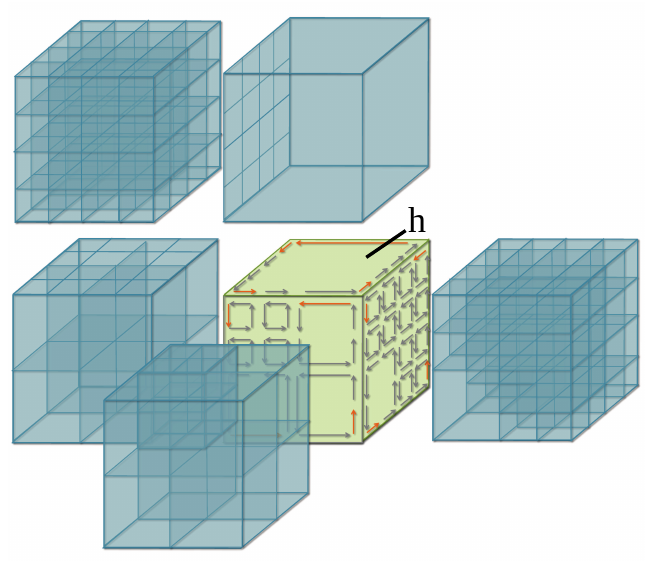
Figure 4. Illustration of a configuration that can occur when using an adaptive subdivision in a hexahedral mesh (image from